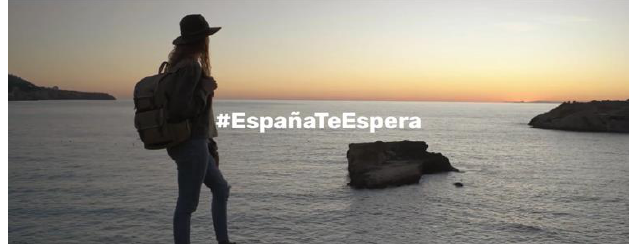
Figure 3. Capture of the “Itxaropena” campaign.